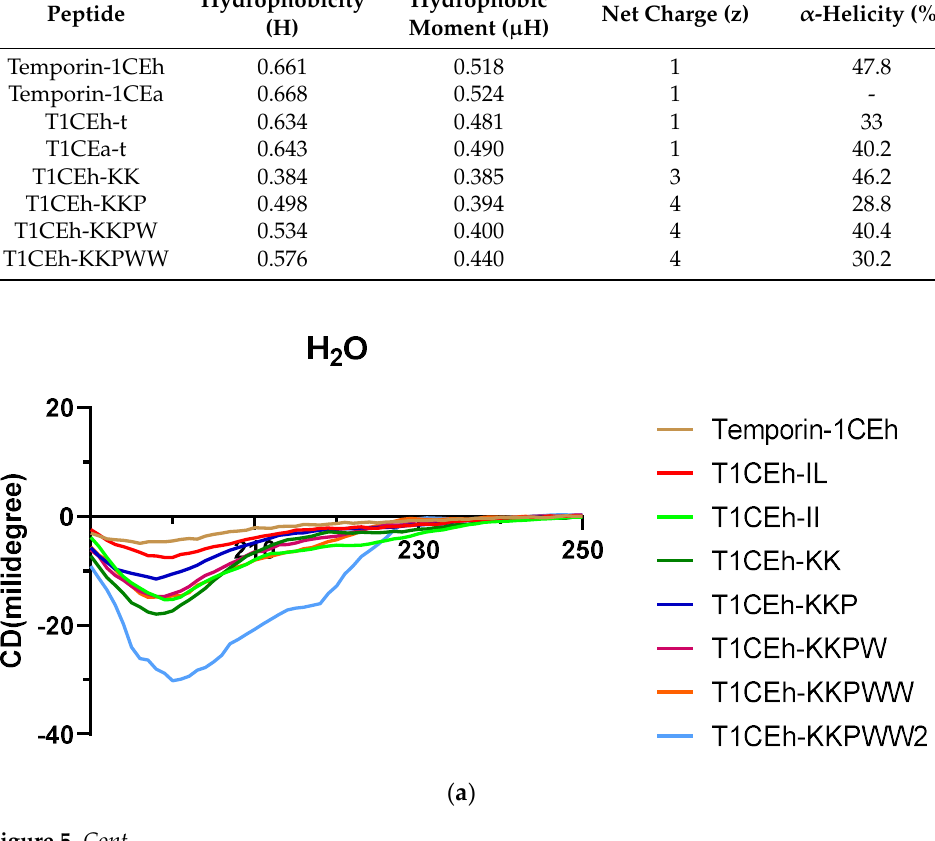
Table 2. The MICs and MBCs of Temporin-1CEh and its analogues as well as Temporin-1CEa against the S. aureus (ATCC CRM 6538), MRSA (NCTC 12493), E. faecalis (NCTC 12697), E. coli (ATCC 8739), P. aeruginosa (ATCC 27853) and K. pneumonia (ATCC 43816), as well as the MICs of Temporin-1CEa against S. aureus and E. coli [29].